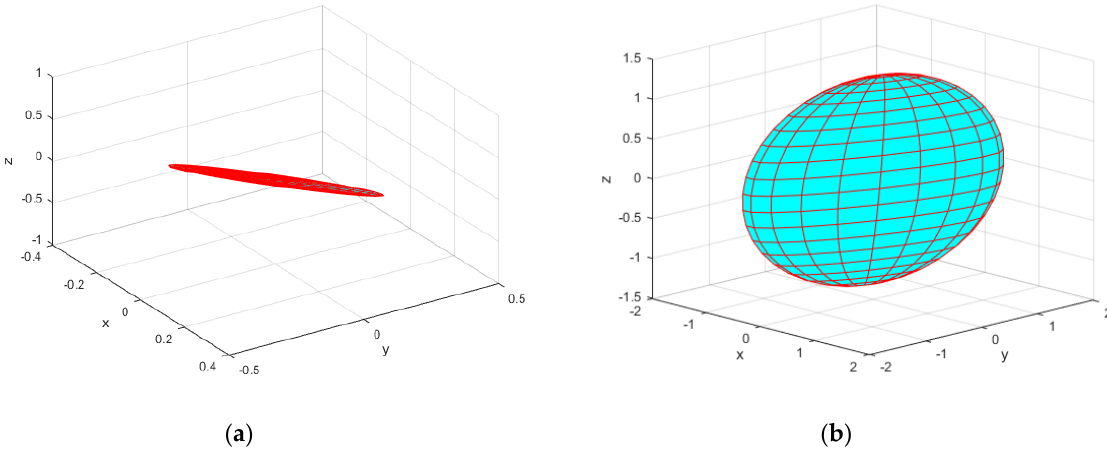
Figure 14. The EE velocity ellipsoid with d 1 = 0.3, q 5 = q 4 = 0 ( ± π ) , and q 2 = q 3 = q 6 = q 7 = π /3. ( a ) Translational velocity ellipsoid; the ellipsoid is an elliptical plate. ( b ) Rotational velocity ellipsoid.